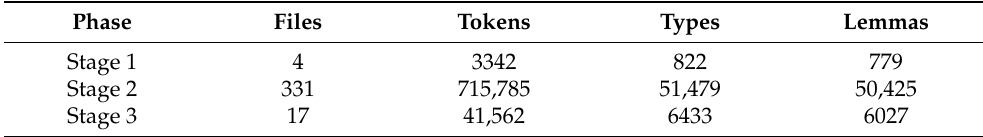
Table 2. The specific descriptions of the three